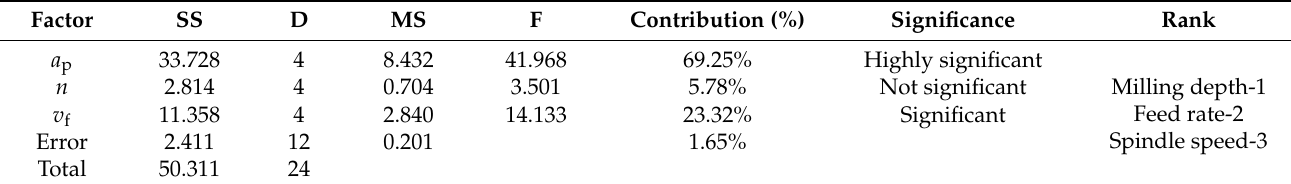
Table 6. Variance analysis results of milling load orthogonal experiment.